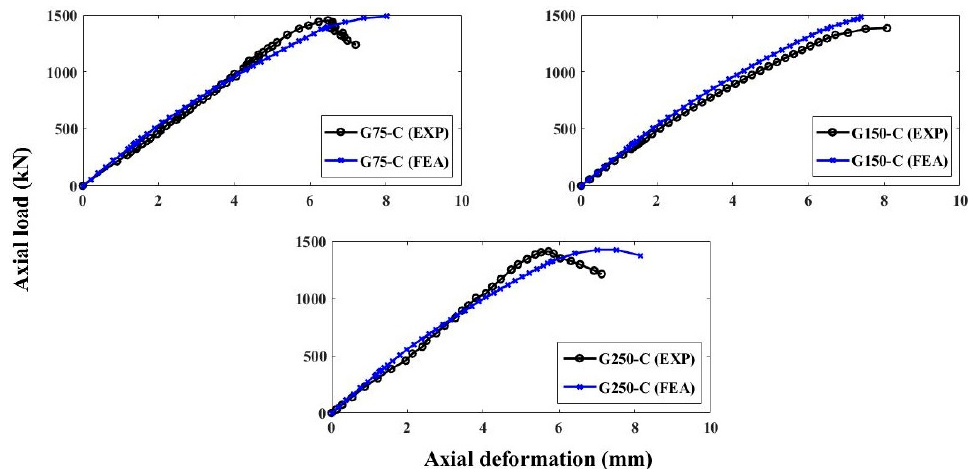
Figure 11. Load-deflection performance of GFRP-RC concentric columns.